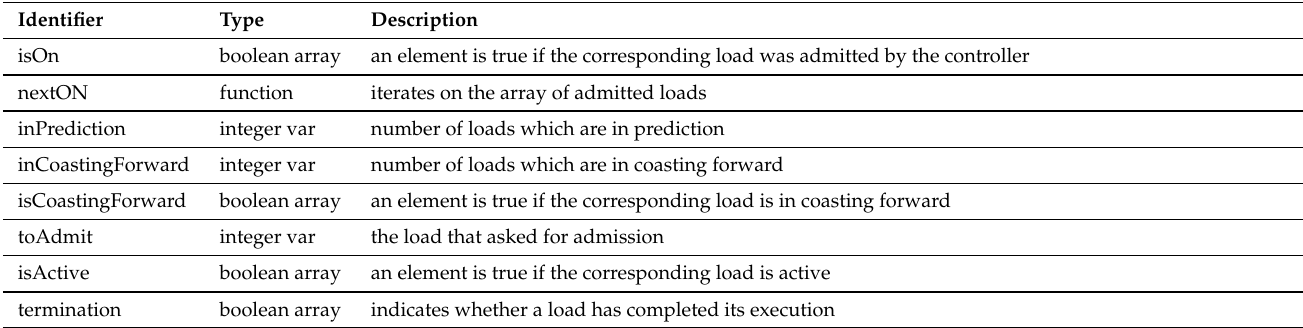
Table 2. Variables and functions exploited by the Controller actor.